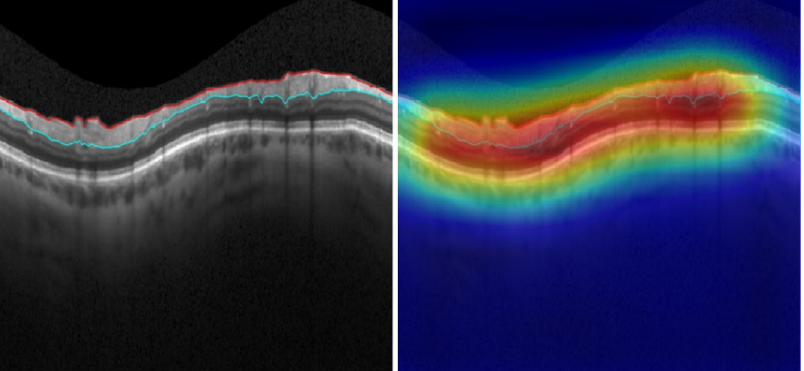
Figure 2. Spectral-domain optical coherence tomography (SDOCT) B-scan with no segmentation error, as labelled by human graders and the deep learning algorithm. Class activation map (heatmap) involves the whole B-scan, rather than being concentrated on a particular area. The probability of segmentation error given by the deep learning algorithm was below 1%.